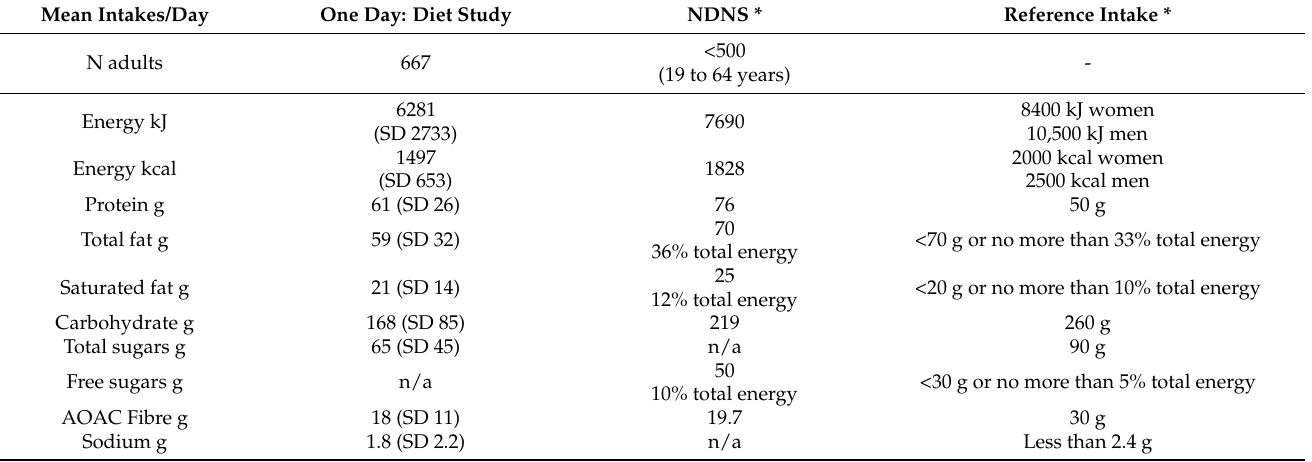
Table 2. Food and nutrient intakes